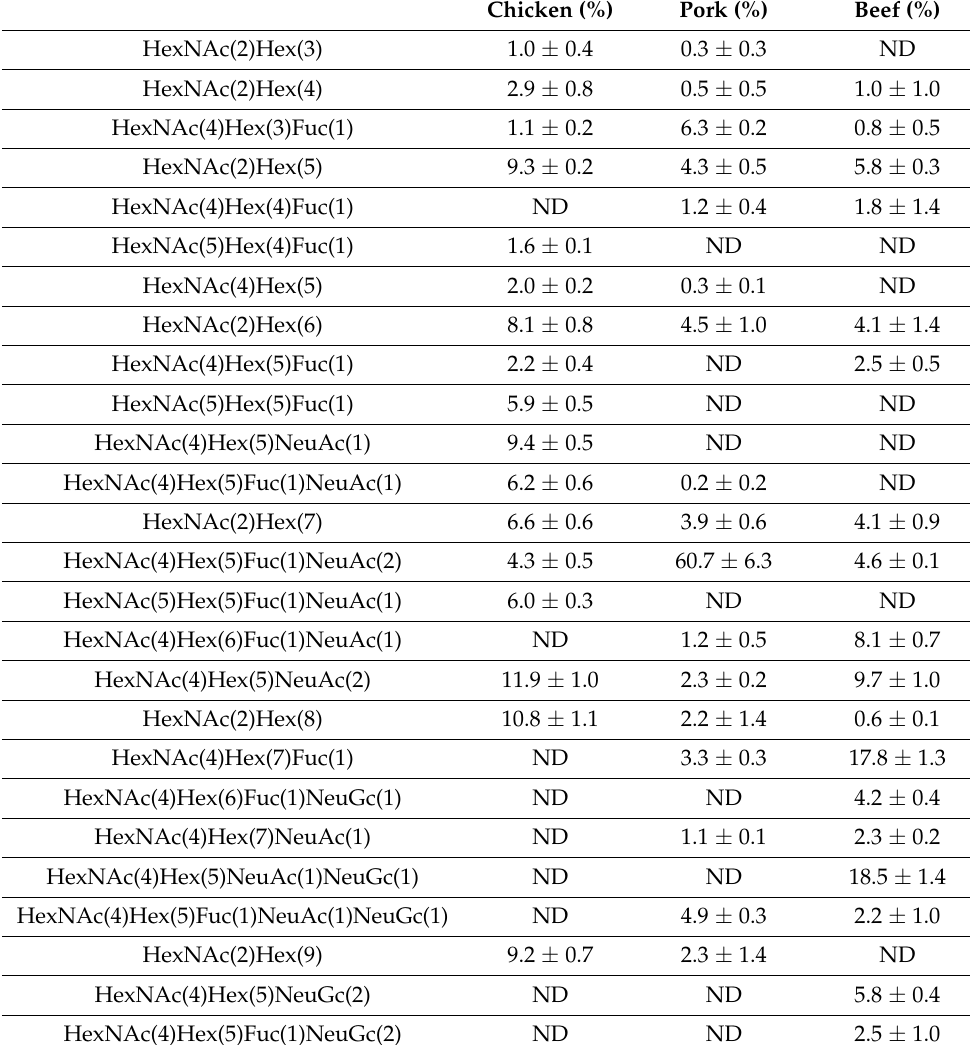
Table 2. Summary of relative abundances of N-glycans detected in chicken, pork, and